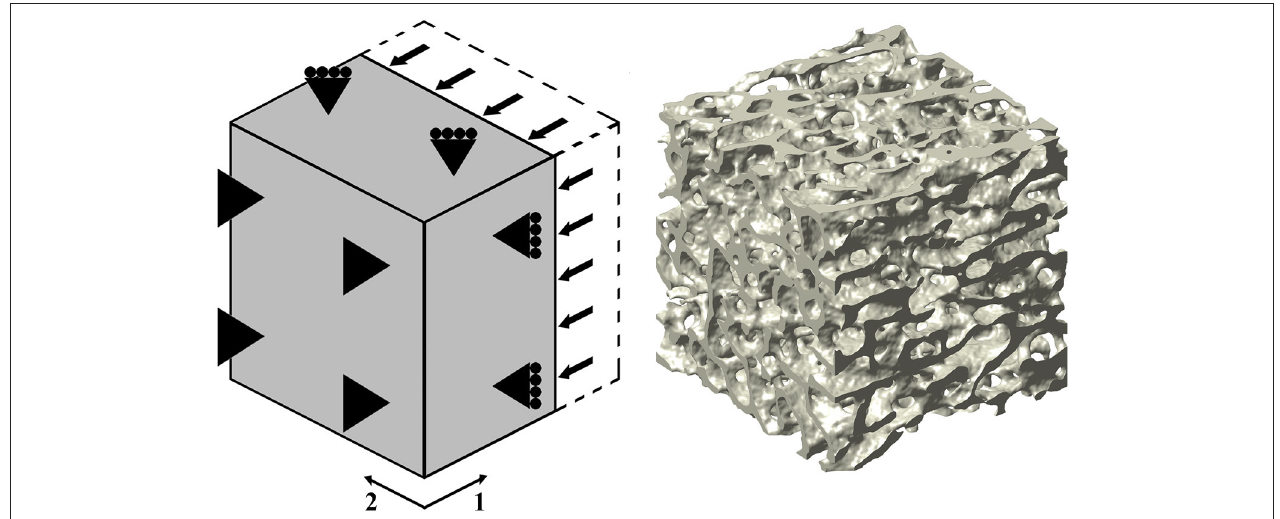
FIGURE 1 | (Left) Three-dimensional graphical depiction of the strain-controlled compressive load case in direction 1 (load case 4 in Table 1 ). (Right) Rendered image of one of the used trabecular bone specimens; this particular sample led to a FE mesh of ∼ 21M degrees of freedom.